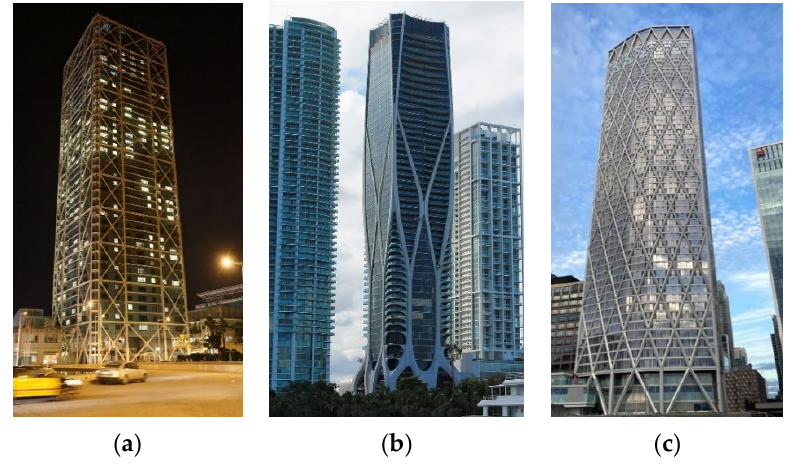
Figure 1. ( a ) Hotel Arts—Barcelona [1]; ( b ) One Thousand Museum—Miami [2]; ( c ) Newfoundland—London [3].